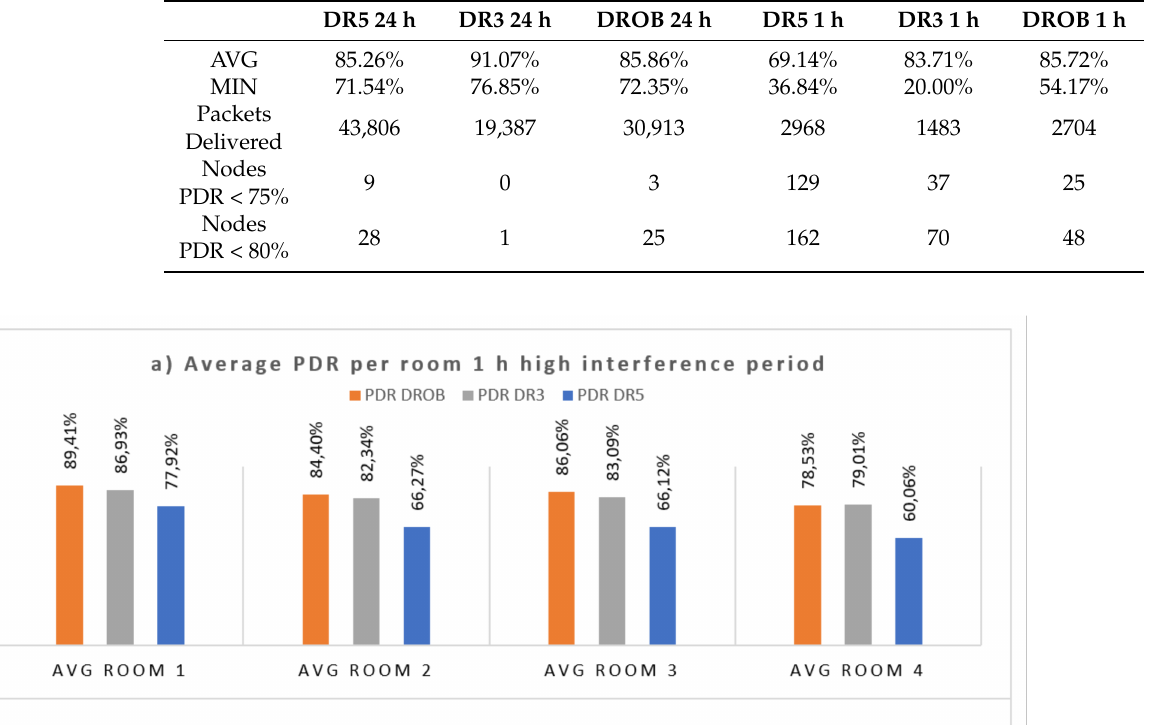
Table 4. Overall network results for DROB and fixed DR configurations.